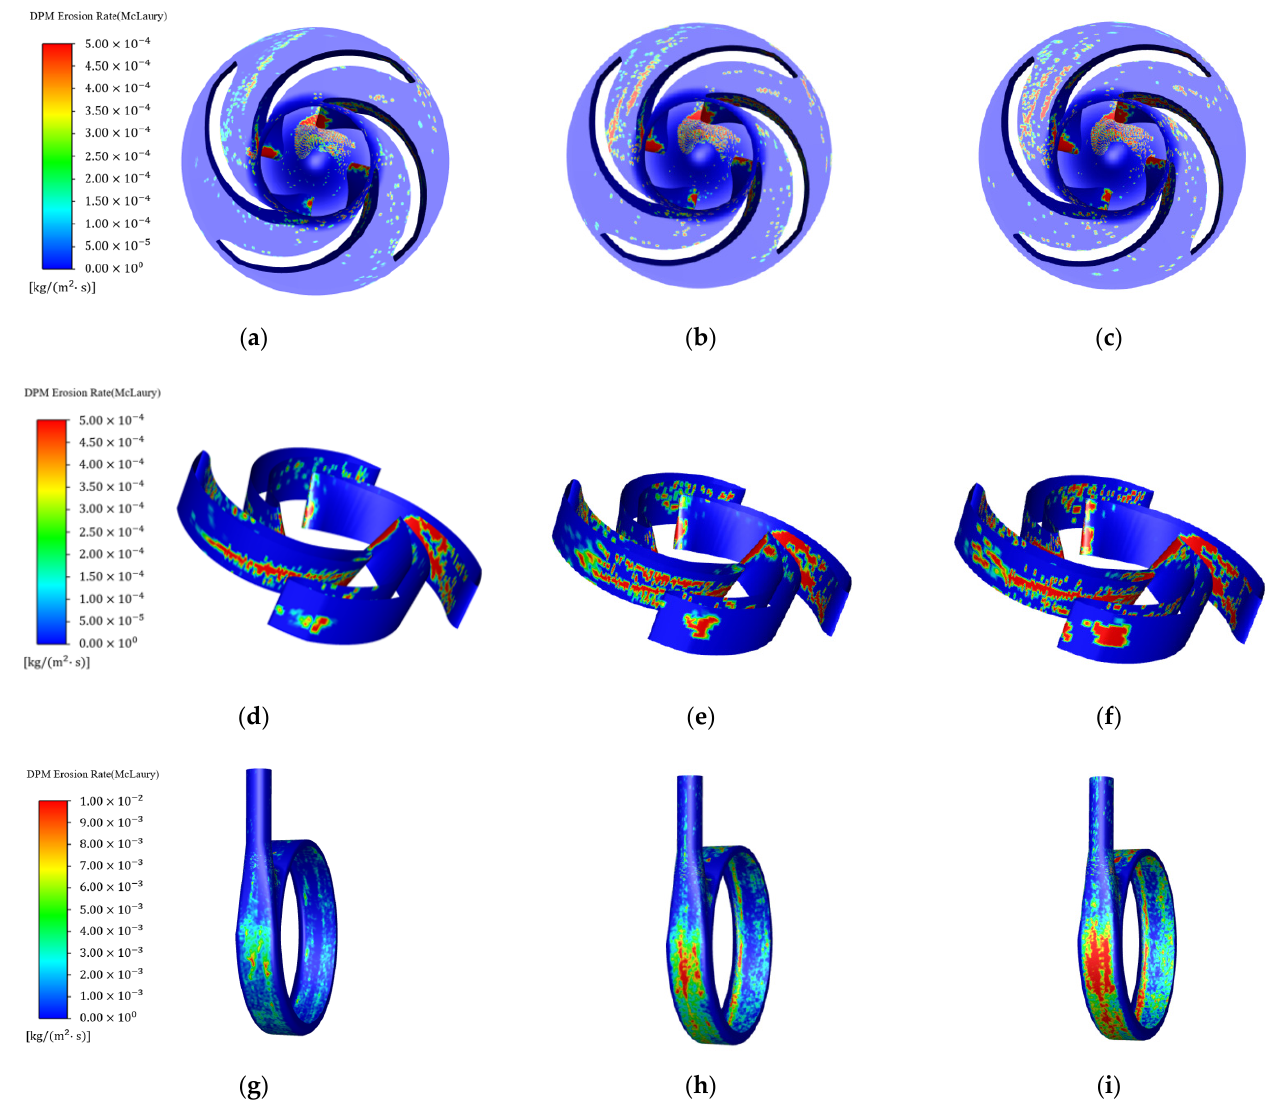
Figure 19. Wear distribution of each fraction at different solid volume fractions: Impeller inlet: ( a ) C V = 5%; ( b ) C V = 10%; ( c ) C V = 15%; Blades: ( d ) C V =5 %; ( e ) C V = 10%; ( f ) C V = 15%; Volute: ( g ) C V = 5%; ( h ) C V = 10%; ( i ) C V = 15%.